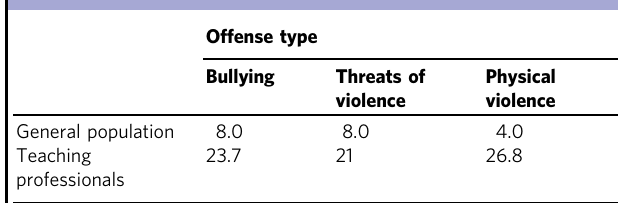
Table 2 Self-reported experience of offensive behaviors